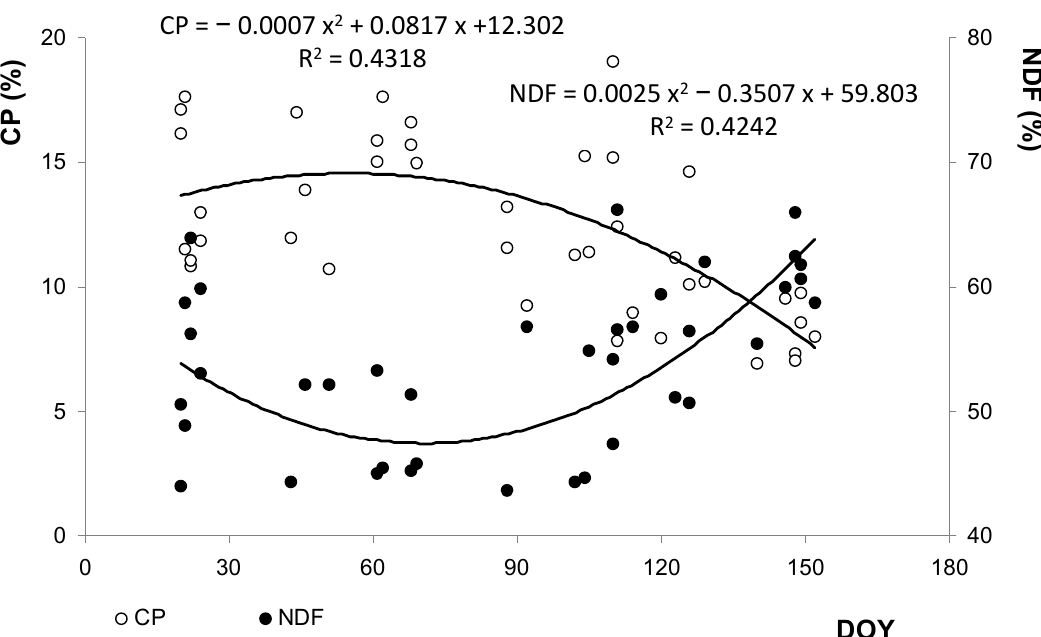
Figure 17. General pattern of mean pasture CP and NDF in function of DOY, for the set of experimental fields and pasture sampling dates (2019 and 2020).